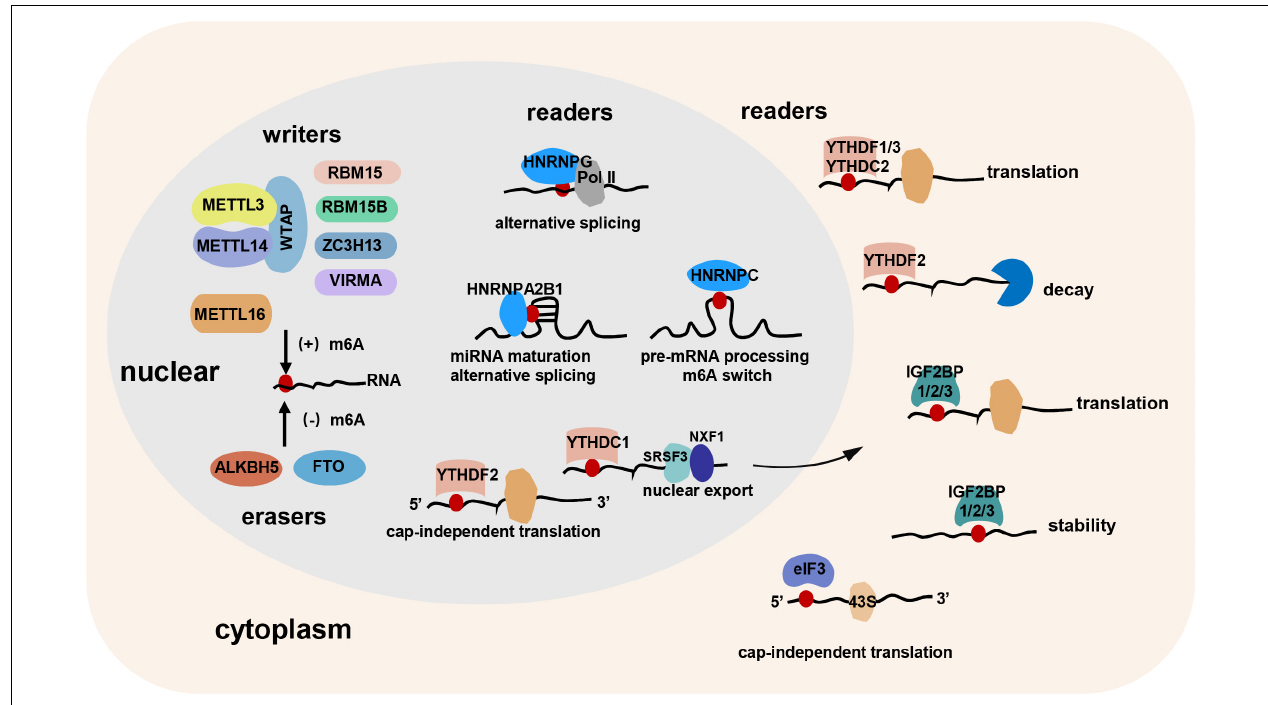
FIGURE 1 | The “writers,” “erasers,” and “readers” of m6A RNA modification. “Writers,” “erasers,” and “readers” are responsible for the occurrence, removal, and recognition of m6A modification, respectively. METTL3, METTL14, and WTAP constitute the core component of the methyltransferase complex. RBM15, RBM15B, ZC3H13, and VIRMA may bind to the complex. In addition, METTL16 might be an independent m6A methyltransferase. FTO and ALKBH5 are the two m6A demethylases. m6A “readers” contain YTH domain family, IGFBP family, hnRNP family, eIF3, and so on. Cytoplasmic “readers,” including YTHDF1, YTHDF2, YTHDF3, YTHDC2, IGF2BP1/2/3, and eIF3 can regulate the translation, decay, stability, and cap-independent translation of RNA. Nuclear “readers,” including YTHDC1, YTHDF2, HNRNPC, HNRNPG, and HNRNPA2B1 can modulate miRNA maturation, alternative splicing, cap-independent translation, nuclear export, and pre-mRNA